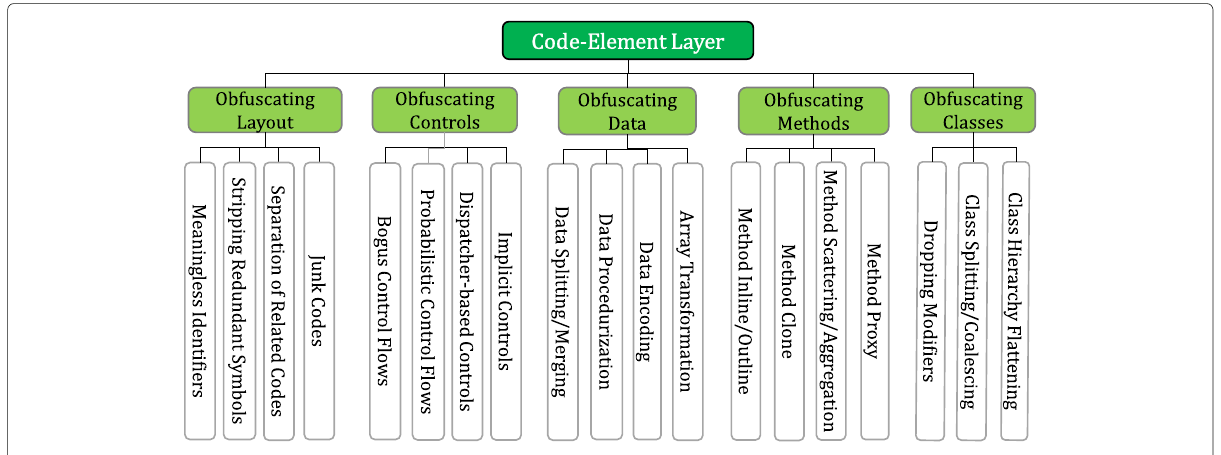
Fig. 4 The obfuscation techniques of code-element